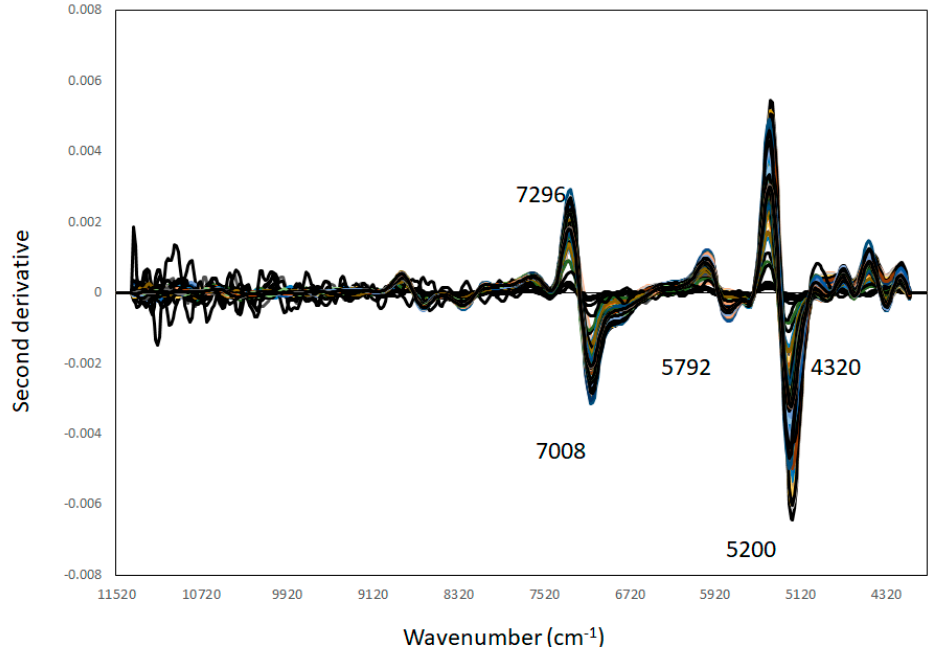
Figure 1. Second derivative NIR spectra obtained from 5th instar larvae and 6th instar pre-pupae reared on soy waste and spent brewer’s grains.